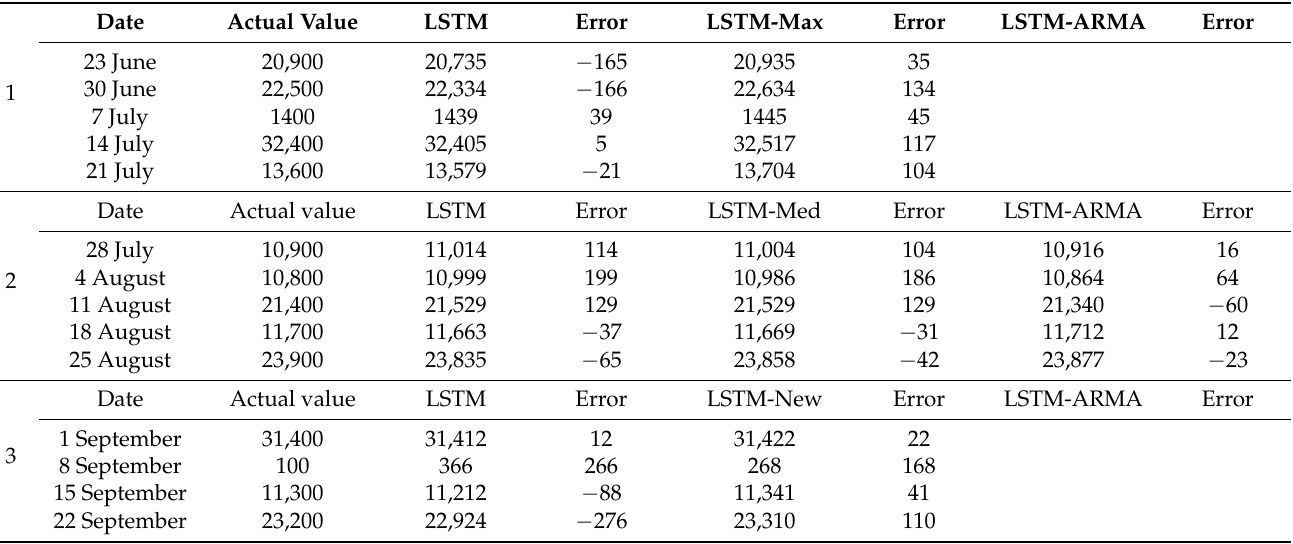
Table 9. BGA 8X12.5 rolling forecast results summary.